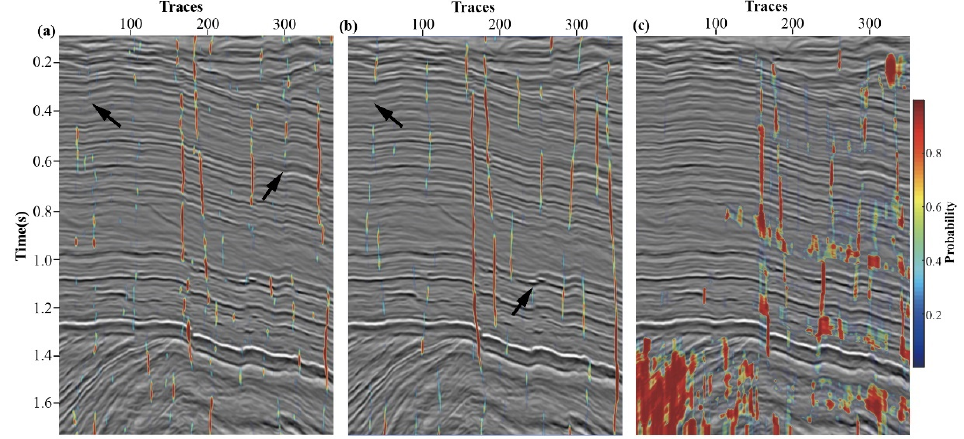
Figure 10. Comparison of fault detection results on Kerry3d section with Net2 ( a ), Net3 ( b ), and seismic coherence ( c ).